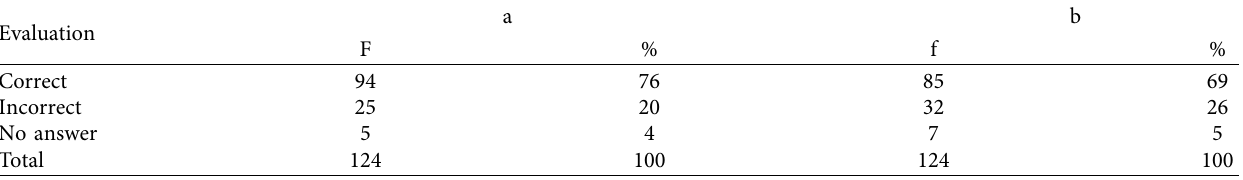
Table 12: Distribution of students’ answer to question 6.